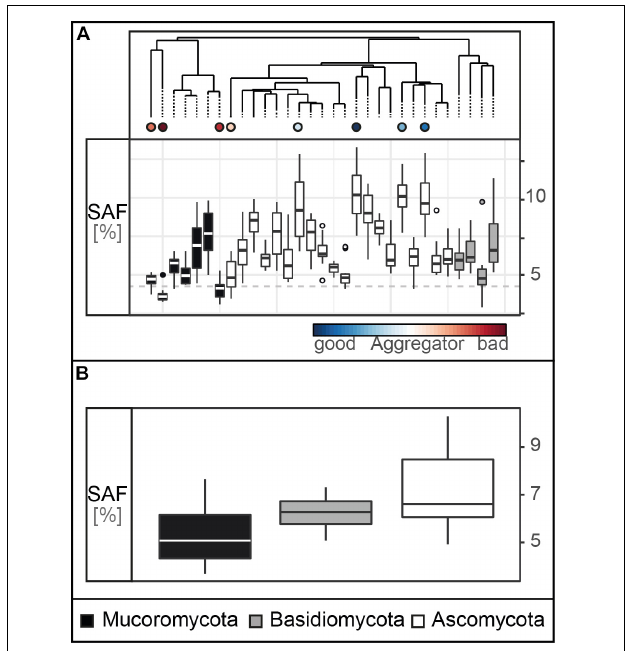
FIGURE 2 | Soil aggregate formation (SAF) capability. (A) Tukey boxplots of the SAF (with n = 10 × 31 in %) capability of the 31 fungal strains. The dashed line represents the average SAF of the controls ( n = 10, mean = 3.5, SD = 0.59). (B) SAF capability depicted on phylum level (pairwise comparisons: Ascomycota – Basidiomycota: p = 0.47, Ascomycota – Mucoromycota: p = 0.03, Basidiomycota – Mucoromycota: p = 0.66; n =